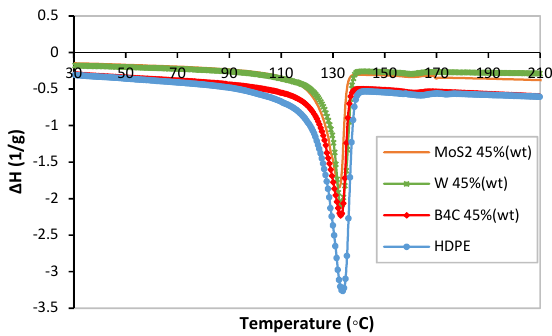
Fig. 14. Heating DSC curves for composite samples containing 45% (wt) fillers at a temperature range of 50 to 200 o C.